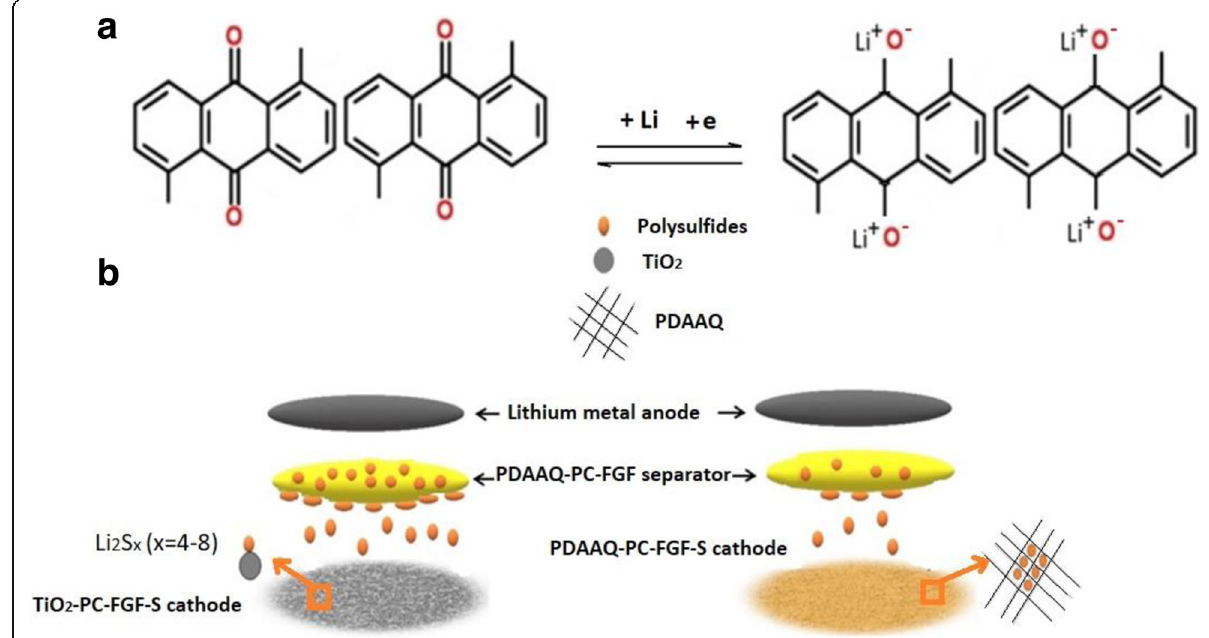
Fig. 1 a Schematic diagram for the lithium ion insertion/deinsertion in the benzoquinone structures of PDAAQ. b Schematics of different polysulfide migration attitudes with two different cathodes